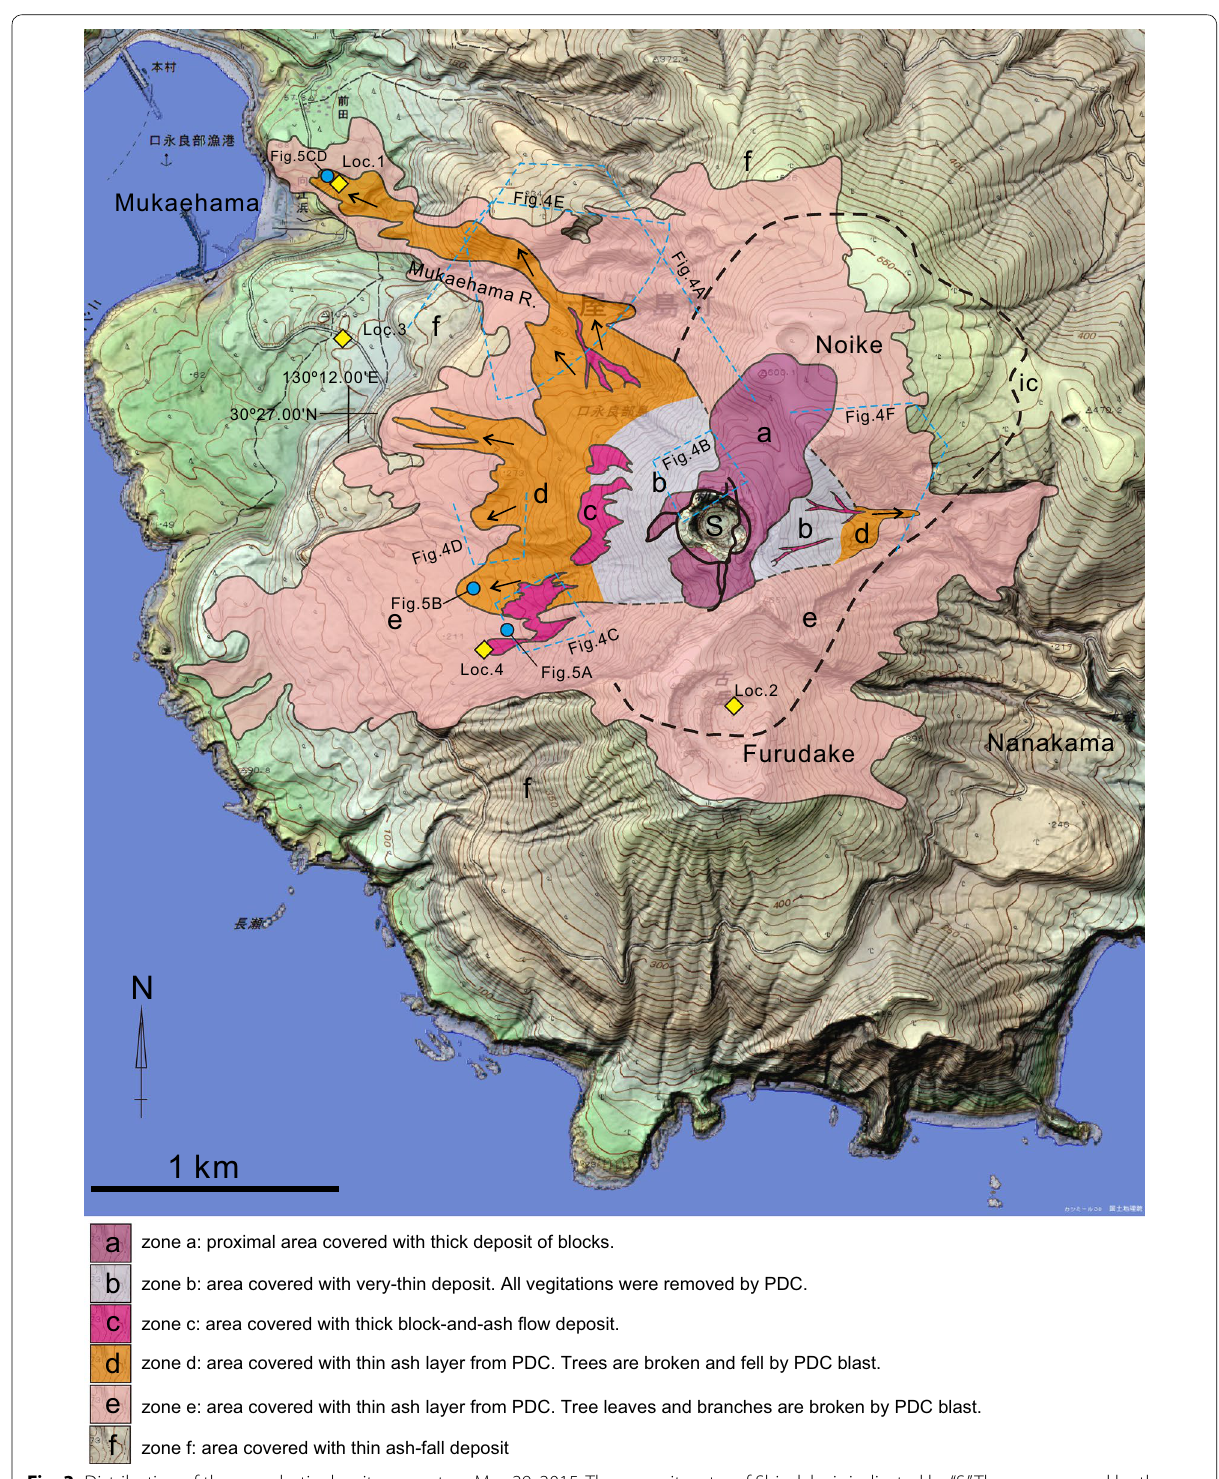
Fig. 3 Distribution of the pyroclastic density current on May 29, 2015. The summit crater of Shindake is indicated by “S.” The area covered by the PDC is subdivided into “Zone a” to “Zone e” based on the thickness of the deposit and the degree of damage to the vegetation. The broken line signed with “ic” is the approximate limit of the dense distribution of impact craters (more than 10 craters per 100 photographs). Blue broken lines show the area of the photographs shown in Fig. 4. Blue circles show the location of the photographs shown in Fig. 5. Diamond symbols indicate locations of the representative outcrops shown in Fig.